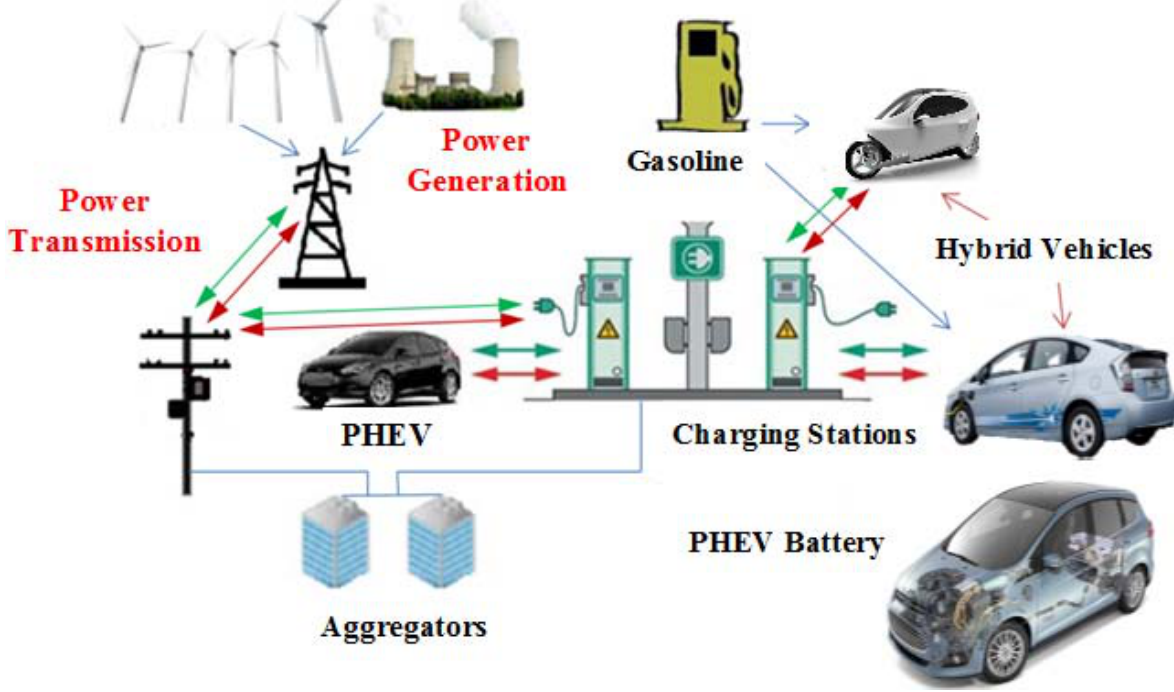
Figure 2. V2G communication in the SG